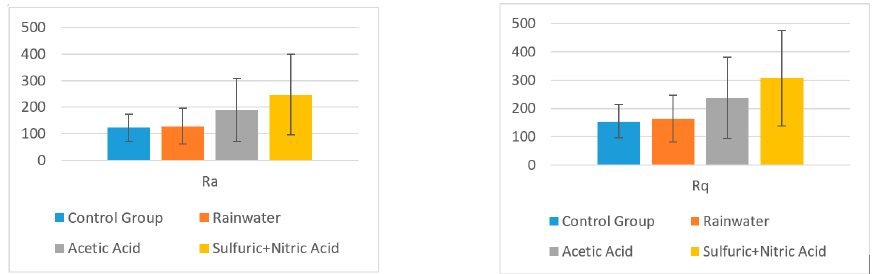
Figure 8. Mean values for Ra and Rq and their standard deviations in different solvents for surface layer.